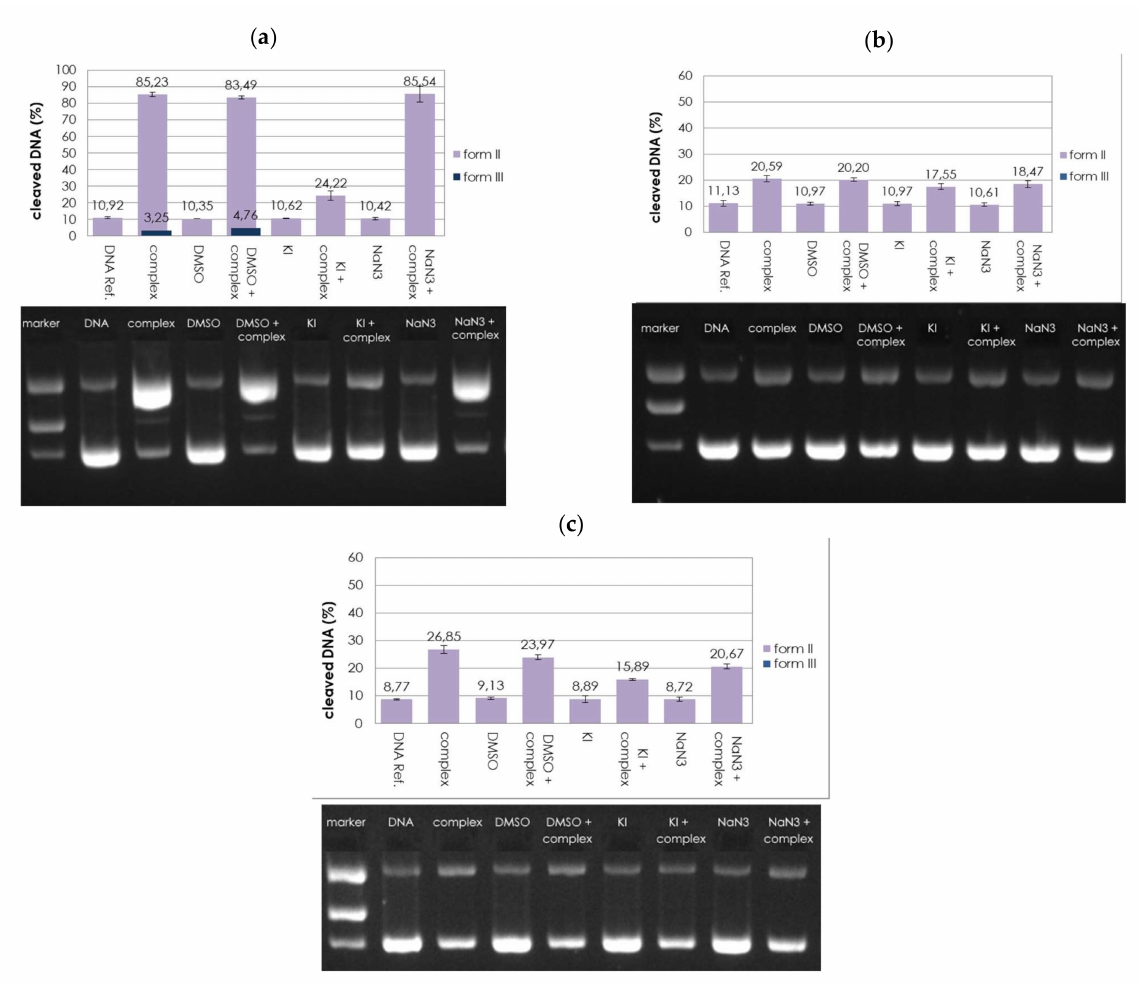
Figure 7. Cleavage of pBR322 plasmid DNA (0.025 µ g/ µ L) by complexes (540 µ M ): ( a ) 1-ClO 4 , ( b ) 2-ClO 4 , and ( c ) 3-ClO 4 after an incubation time of 2 h at 37 ◦ C in the presence and absence of ROS scavengers (0.4 M DMSO, 500 µ M KI, 500 µ M NaN 3 ) in MOPS buffer (10 mM, pH